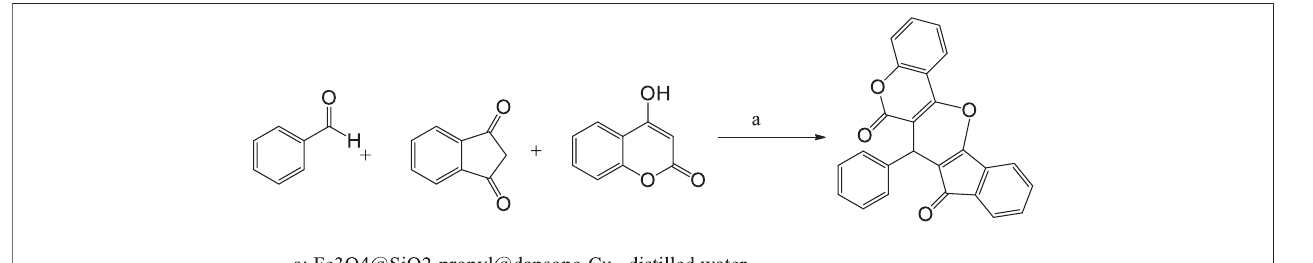
TABLE 1 | The optimization reaction conditions for the synthesis of 4a. Catalyst